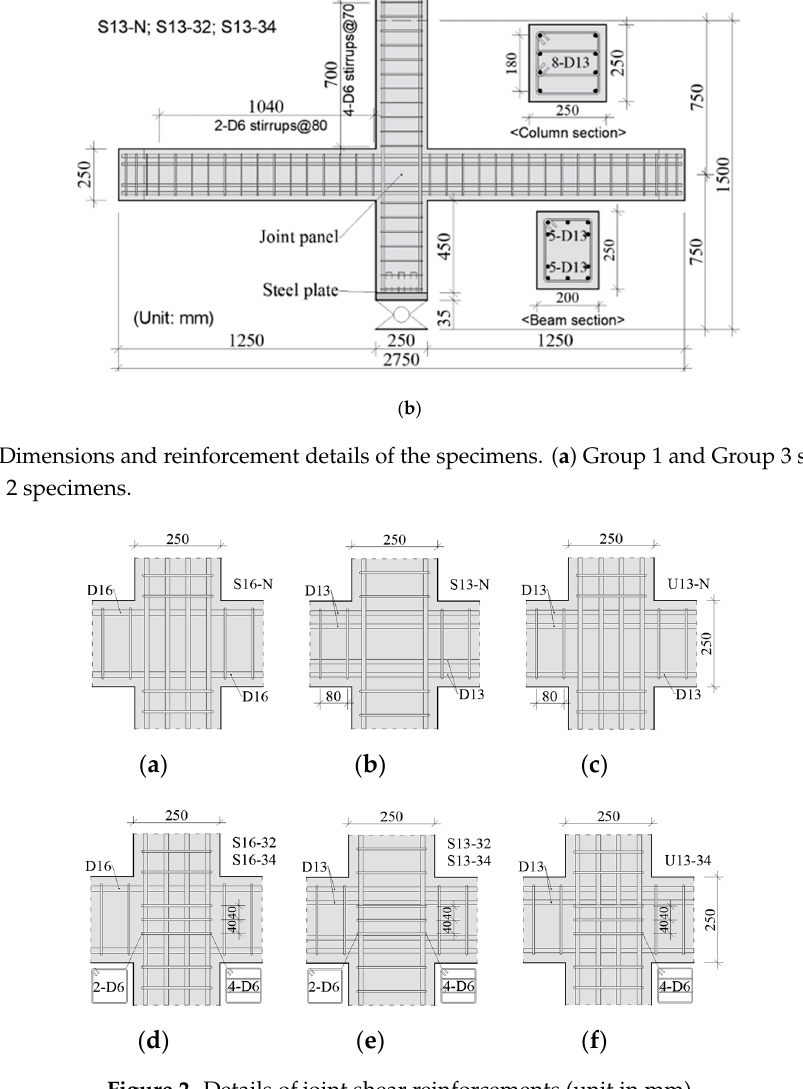
Figure 2. Details of joint shear reinforcements (unit in mm).